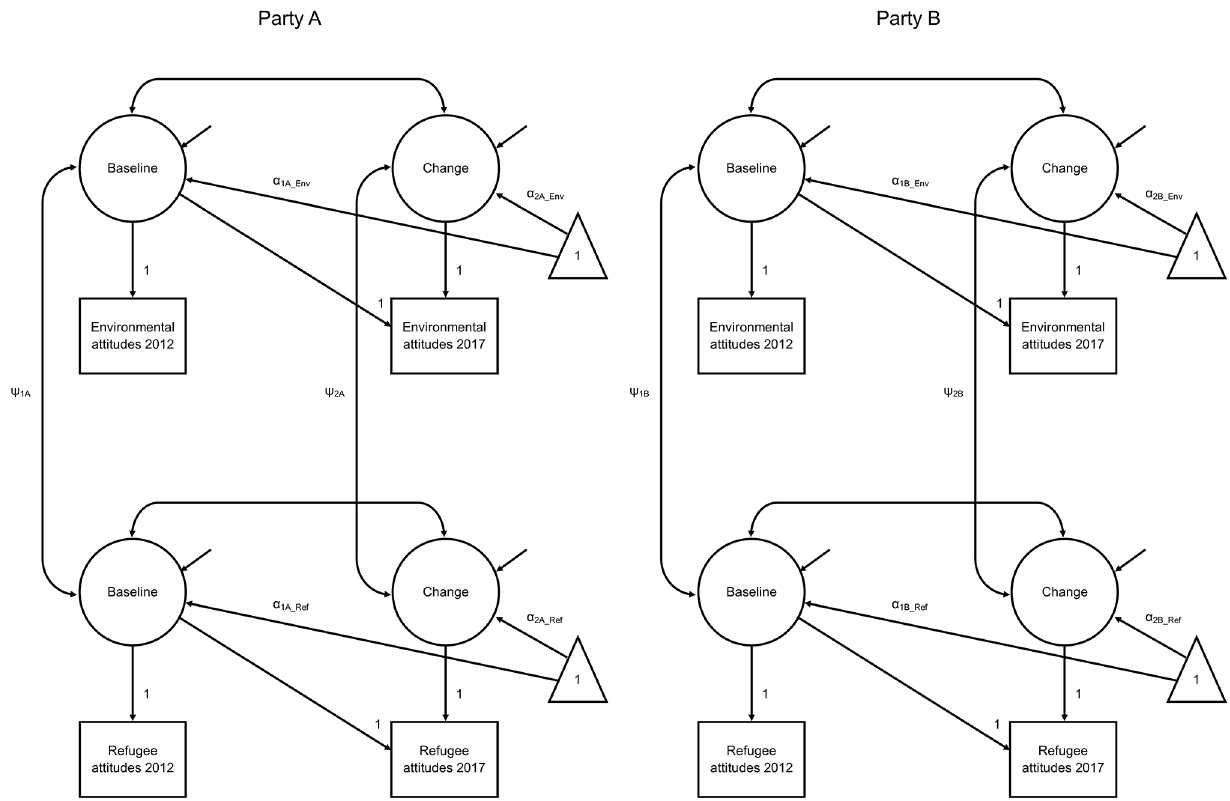
Figure 1. Two-Wave Latent Change Score